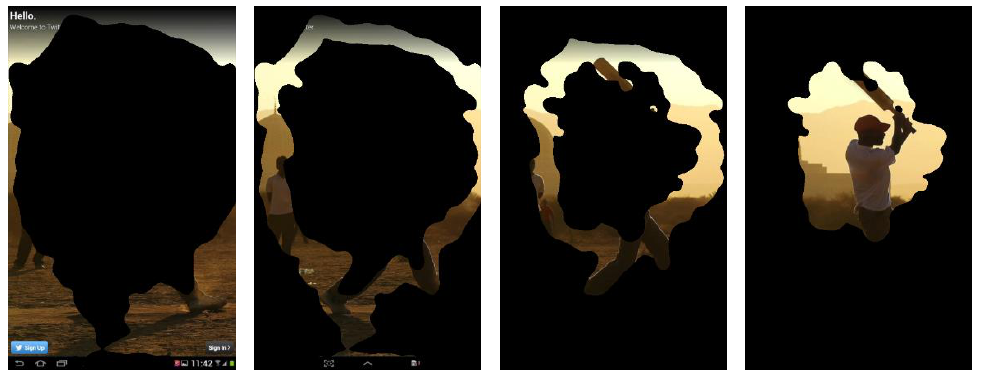
Figure 7. Example of the proposed CovSal saliency clustering method: 4 clusters.